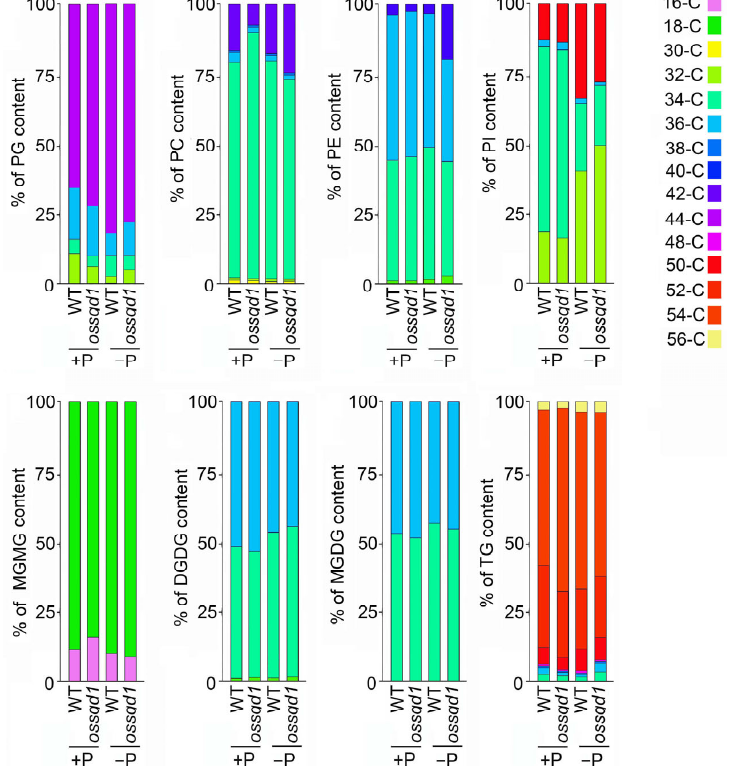
Figure 3. Knockout of OsSQD1 changes the composition of phospholipids and glycolipids in roots under − P condition. Values show the proportion of the different acyl groups (groups of lipid species with the same number of acyl carbons) to the total class content, the sum of the normalized intensities of all the compounds belonging to the same class.